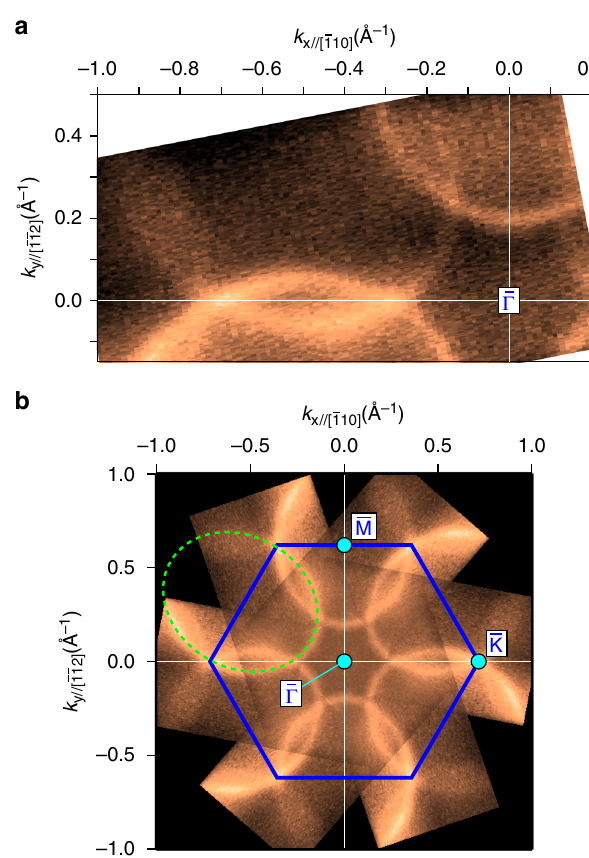
Fig. 2 Fermi contour obtained by ARPES. The ARPES data were taken with circularly polarised photons ( h ν = 35 eV) at 15 K. The ARPES intensities from left- and right-handed polarisations are summed up to show all the states without any in fl uence of circular dichroism. The photon incident plane is slightly shifted from (11 (cid:1) 2) because of small misalignment and angle sweep performed for the ARPES scan. This shift is smaller than 15°. a Fermi contour with an energy window of 10 meV. b Symmetrised Fermi contour based on the three-fold rotation symmetry and time-reversal symmetry. A thick (blue) hexagon is the SBZ boundary of the (1 × 1) surface unit